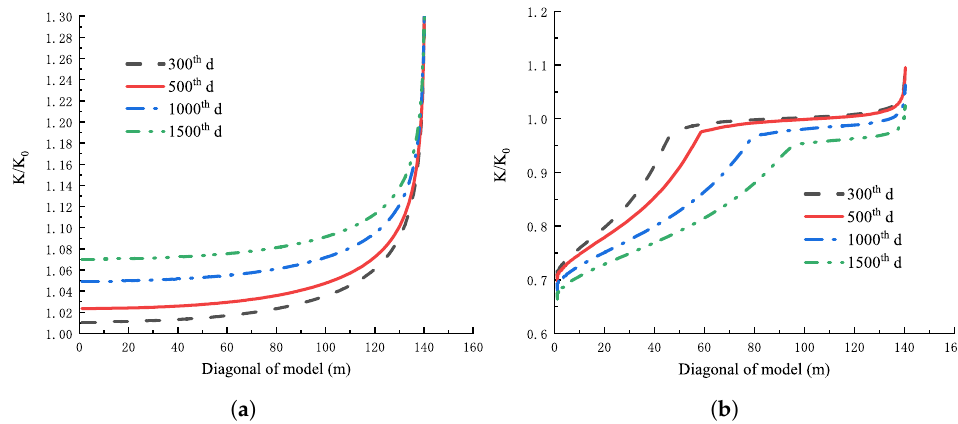
Figure 12. Distribution curve of reservoir permeability along the model diagonal ( a ) CBM ( b ) CO 2 - ECBM